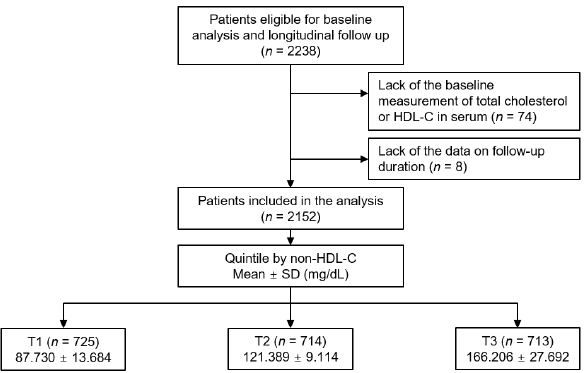
Figure 1. Study design. Abbreviations: HDL-C, high-density lipoprotein cholesterol; nHDL, non- high-density lipoprotein cholesterol; T1, 1st tertile; T2, 2nd tertile; T3, 3rd tertile; SD, standard deviation. 2.2. Data Collection from Participants Demographic information included age, gender, Charlson comorbidity index, pri-